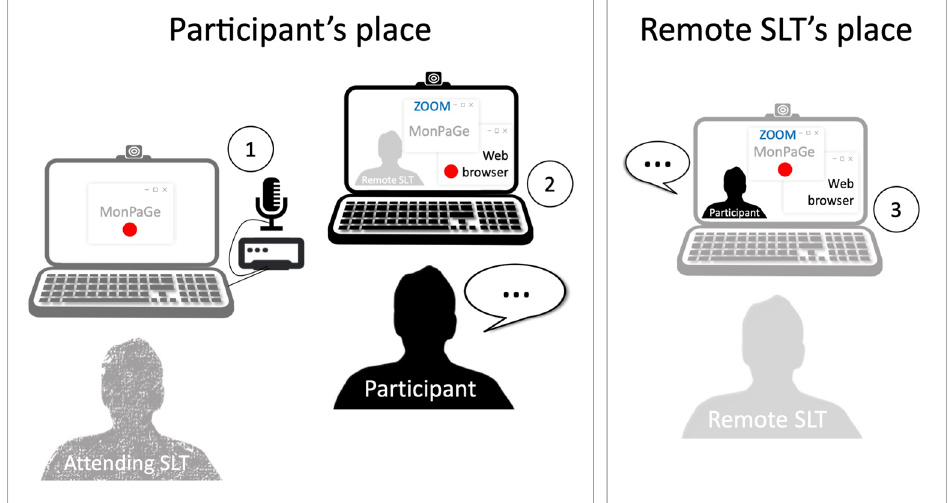
Figure 1. Setting for the simultaneous recording from three sources, namely (1) high-quality in-person hardware (local HQ condition), (2) in-person standard hardware, with software automatically sending audio files online (local SQ condition), and (3) remote standard hardware (online condition). Table 2. Key differences between the three recording conditions .